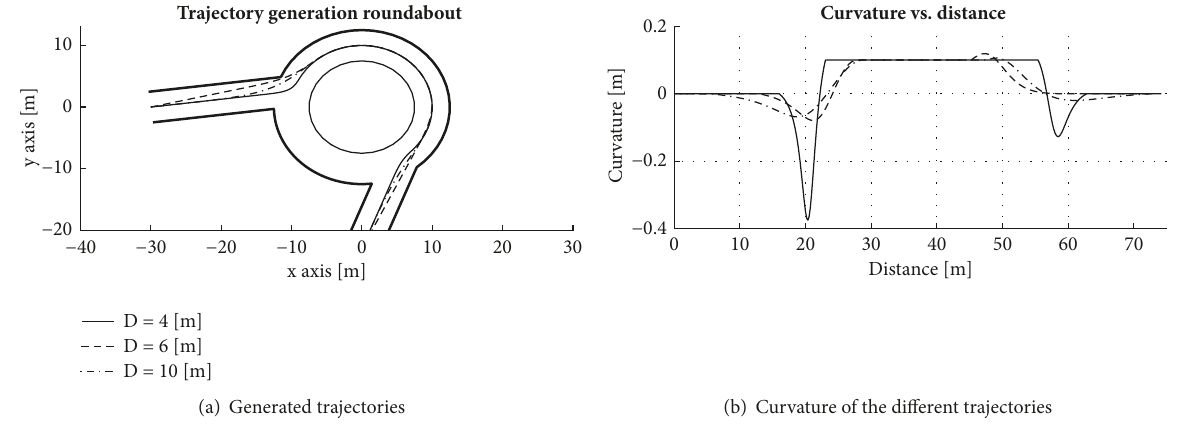
Figure 5: Examples of roundabout trajectories for different D